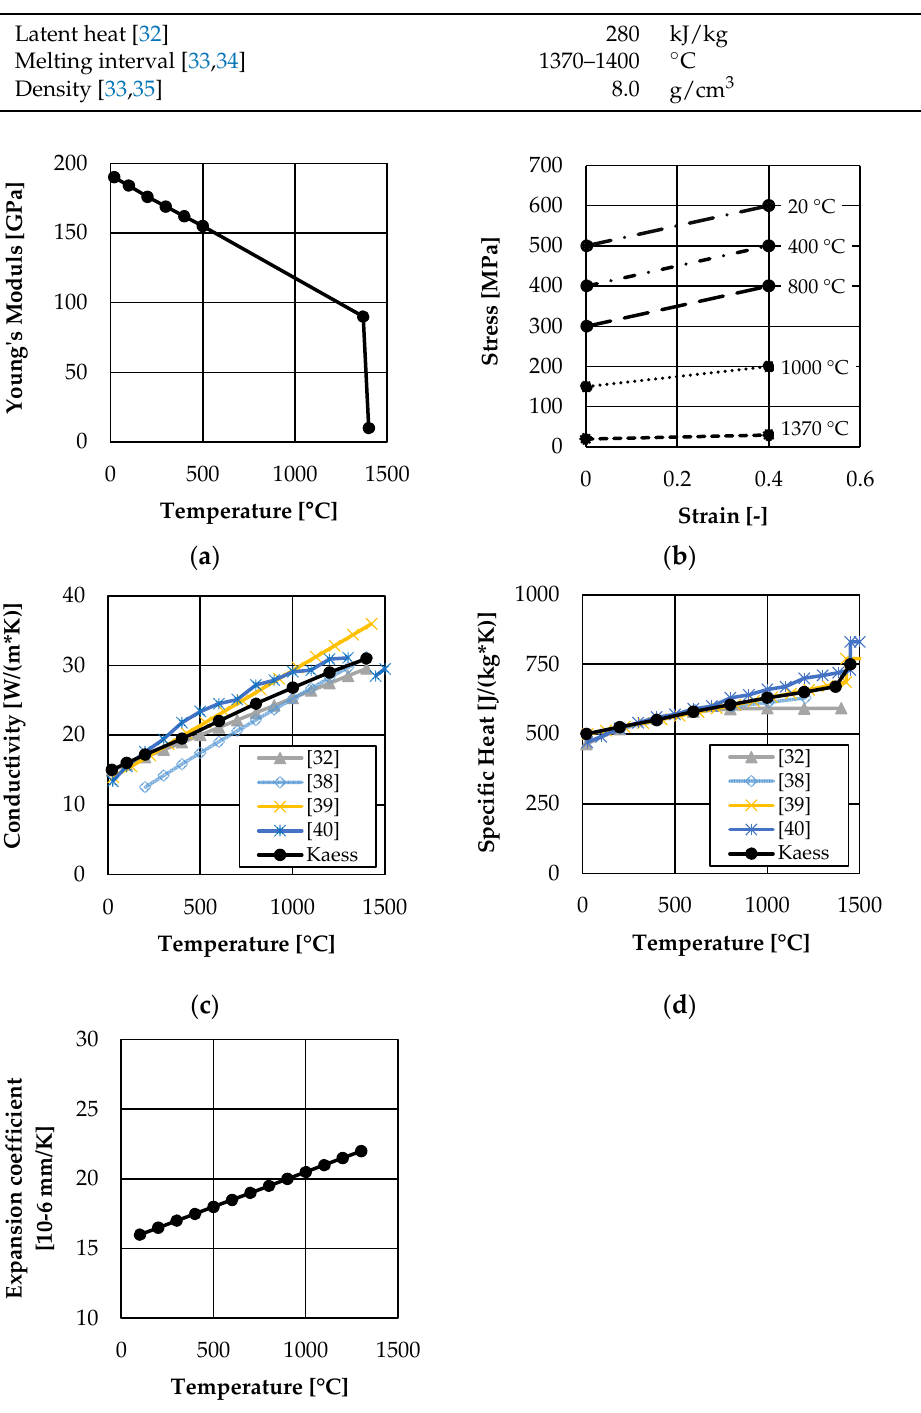
Table 1. Parameters for modeling 316L.